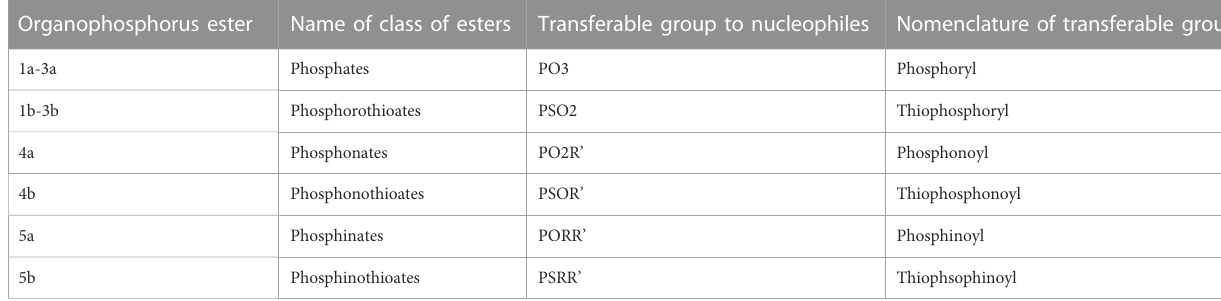
TABLE 1 Nomenclature of the transferable groups in organophosphorus esters 1 – 5 Organophosphorus